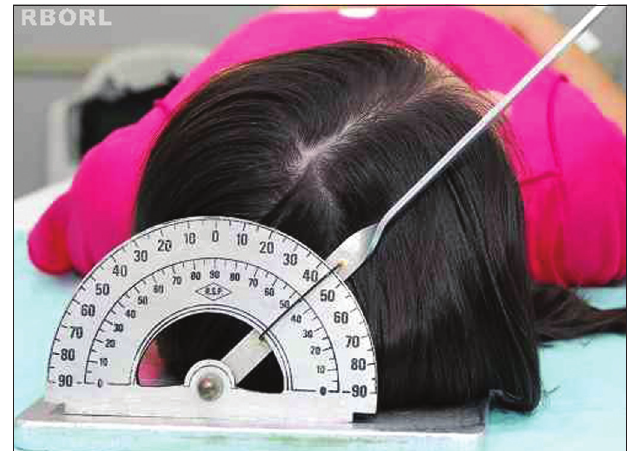
Figura 5 . Posicionamento - plano sagital mediano em 45 ° com a horizontal: Oblíqua lateral (vista posterior).